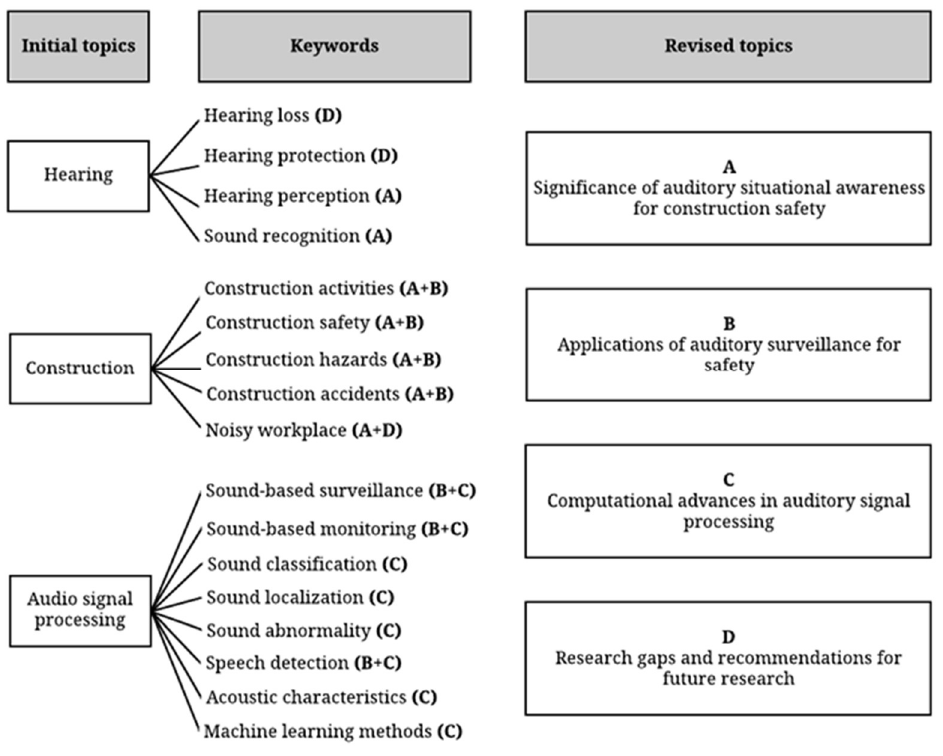
Figure 4. Identify the scope of this review based on